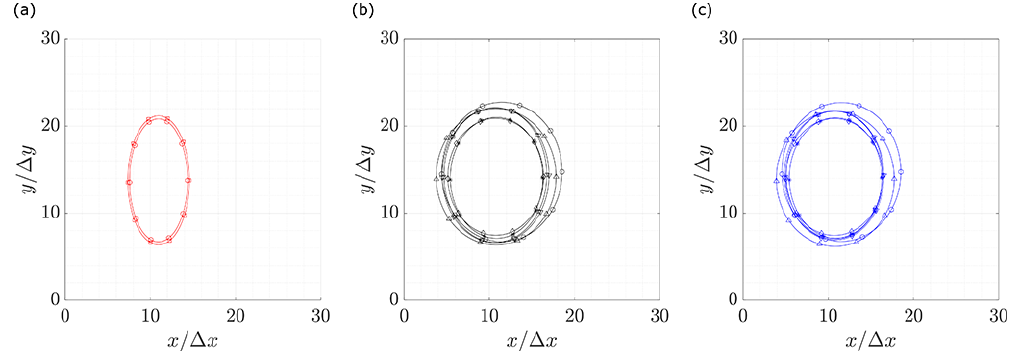
Figure A1. Jittering zone of each VIM and scheme. (a) Graftieaux. (b) Vorticity magnitude. (c) Q criterion.